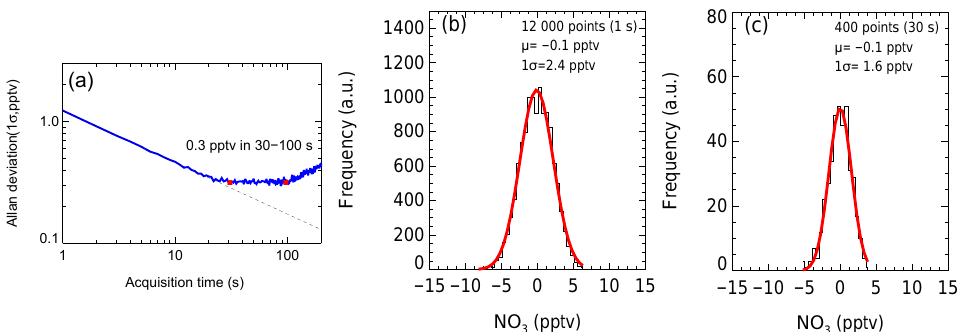
Figure 9. The instrument performance with different integration times. (a) Allan deviation plots for measurements of NO 3 with 1s integration time. Panels (b) and (c) show the histogram analyses of the measurements of NO 3 with 1 and 30s integration time, respectively.